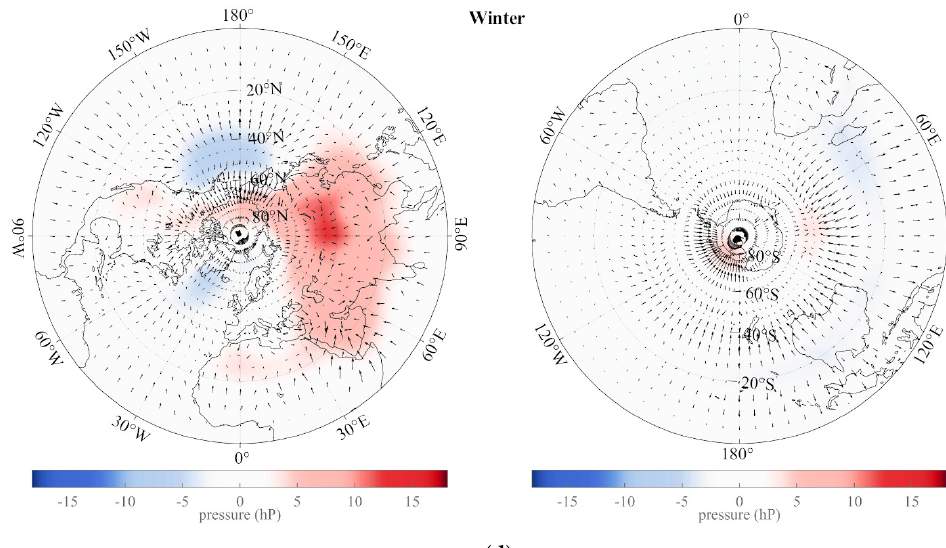
Figure 6. Polar stereographic projection of the northern hemisphere (left column) and southern hemisphere (right column) showing the mean (1850–2020) of the annual oscillation ( iSSA component 2) for all (from top to bottom) springs, summers, autumns, and winters since 1850: ( a ) during springs; ( b ) during summers; ( c ) during autumns; ( d ) during